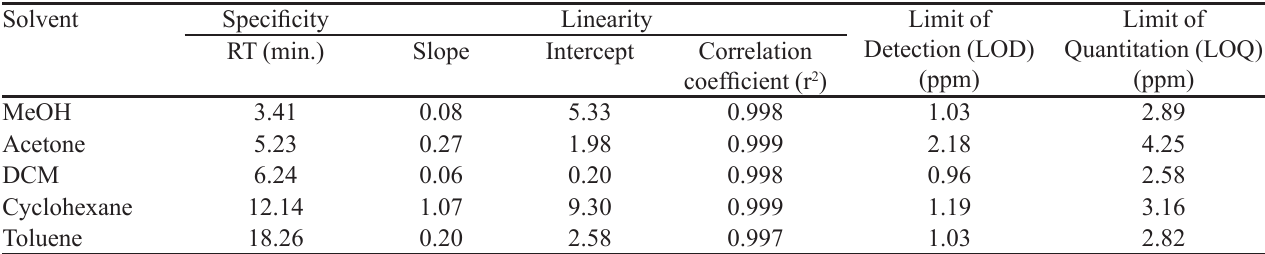
TABLE II - Validation results for residual solvents Solvent